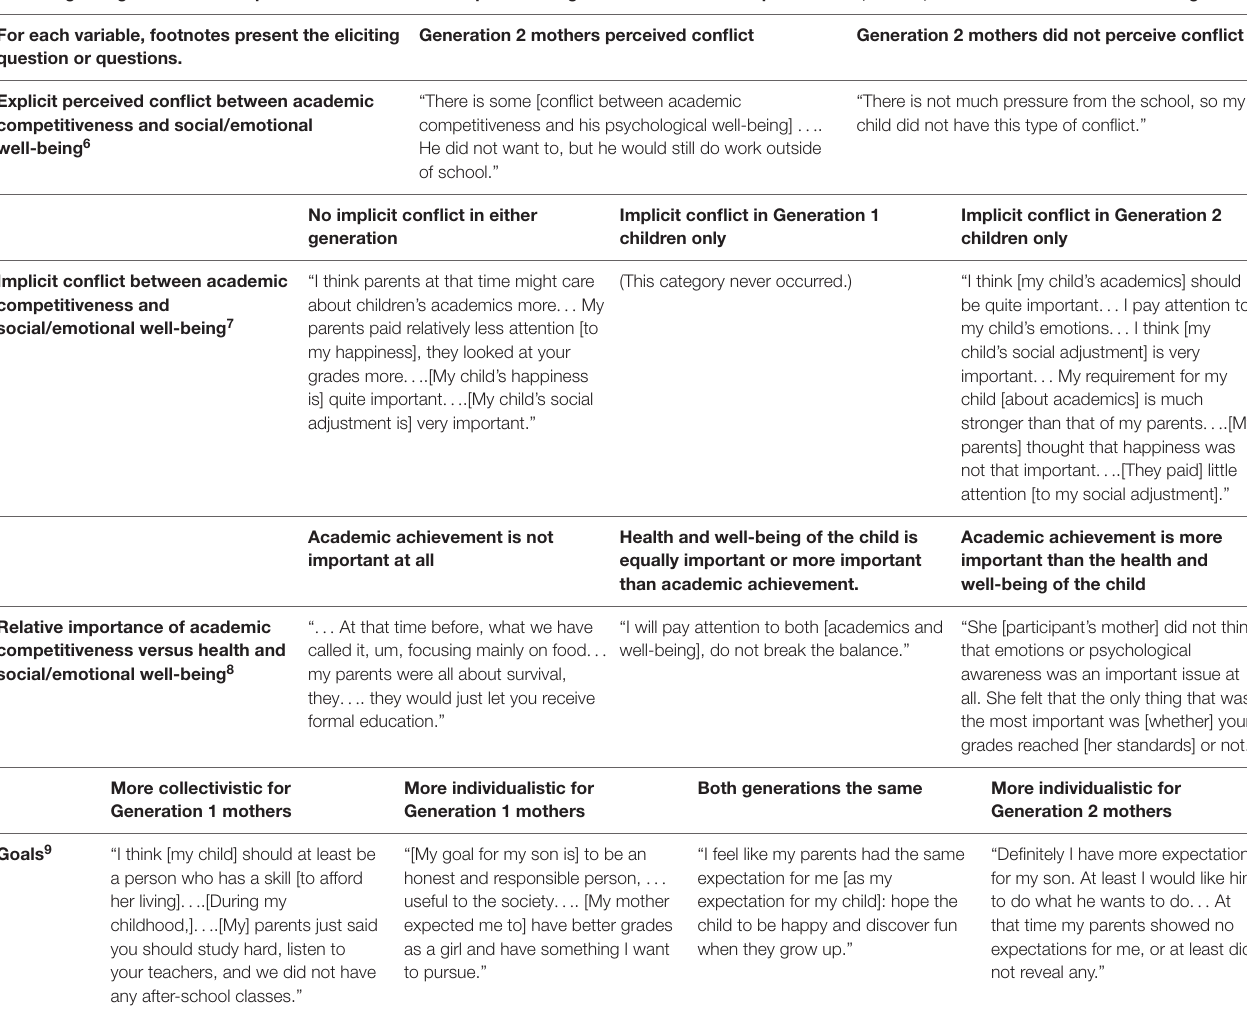
TABLE 1 | Coding categories and examples. A. Coding categories and examples: Goals and relationship between goals of academic competitiveness, health, and social/emotional well-being. For each variable, footnotes present the eliciting question or